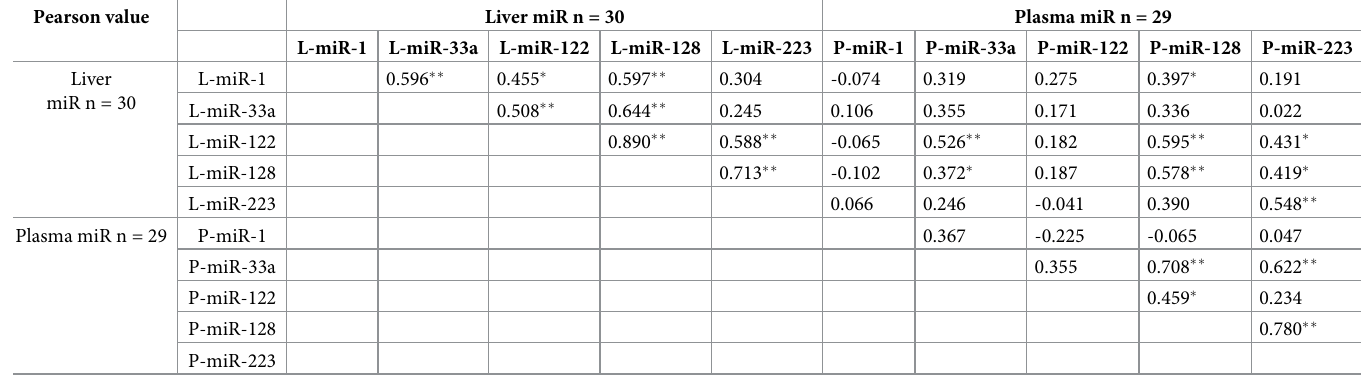
Table 7. Correlations between miRNAs in the liver and plasma of rainbow trout. Pearson